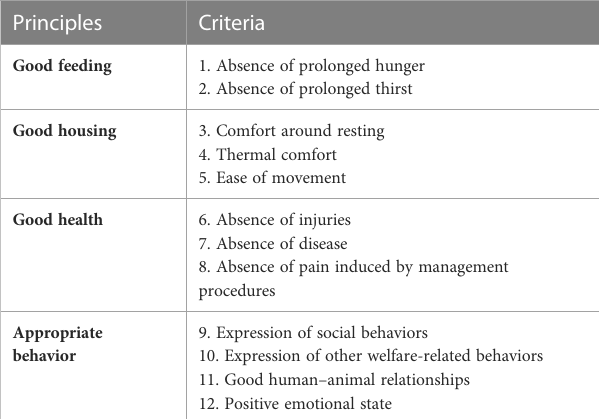
TABLE 1 The Welfare Quality ® principles and criteria (Jones and Manteca,